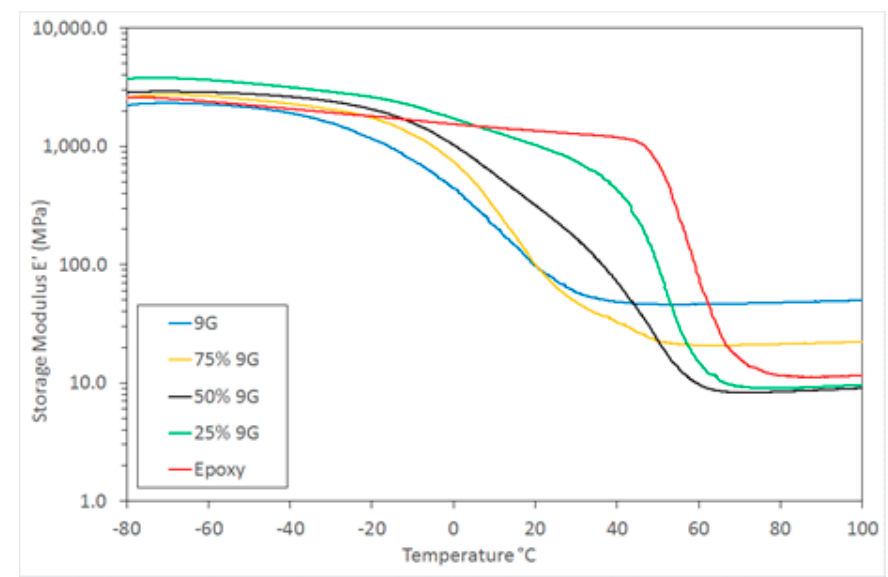
Figure 5. DMTA storage modulus for postcured samples.